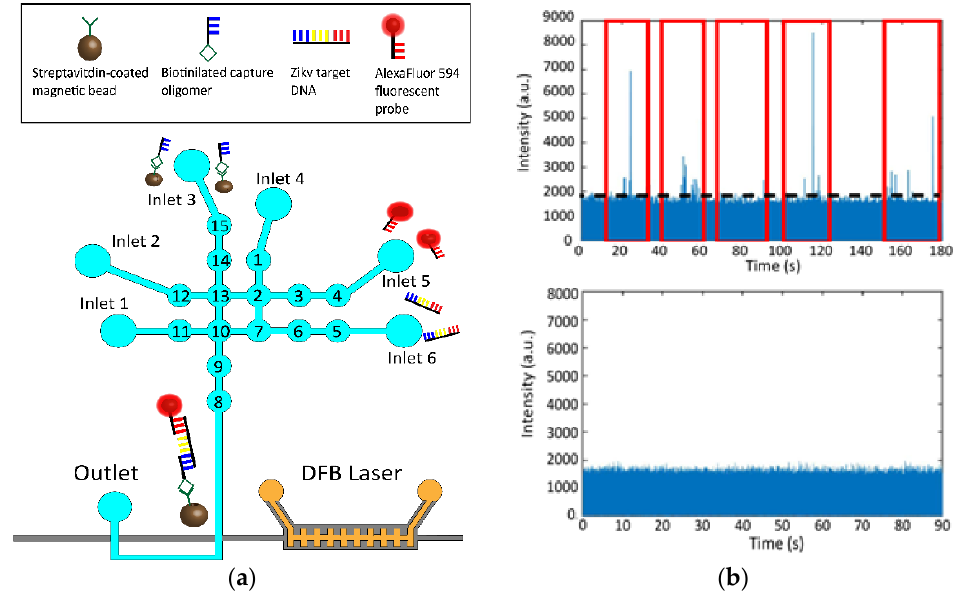
Figure 6. ( a ) Specific Zika assay detection. Magnetic beads with capture probes are loaded into inlet 3 while the AlexaFluor 594 fluorescent probes and Zika target DNA are introduced into inlets 5 and 6, respectively. Samples are brought together into the central mixing valves (13, 2, 7, 10) where they are mixed, heated and incubated for the proper construct to be formed. Beads with captured targets and fluorescent probes are pulled down with a magnet while excess targets and unconjugated probes are washed using buffer. The magnet is then removed, and the complete bead constructs are pushed to the detection region. ( b ) Fluorescence time domain trace illustrating peaks observed from fluorescently tagged bead constructs (top). Control trace done in the absence of Zika targets illustrating no peaks above the noise floor (bottom).